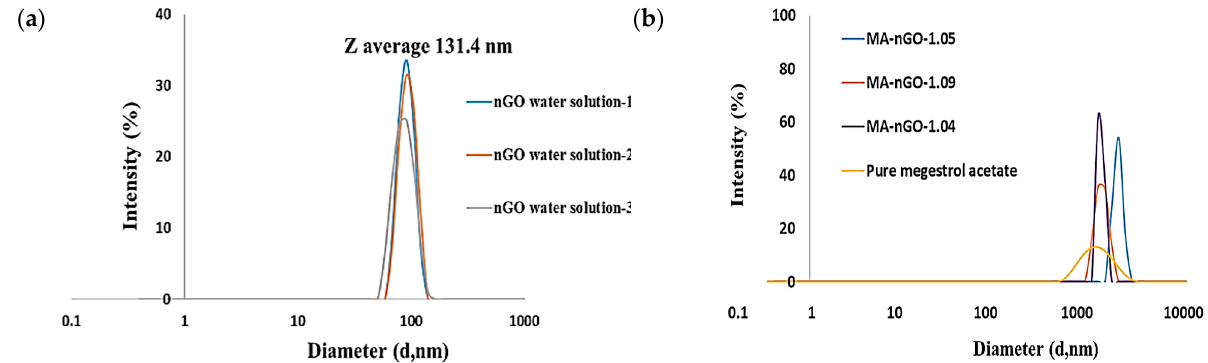
Figure 1. Zetasizer particle size measurement of ( a ) nano graphene oxide (nGO) and ( b ) megestrol acetate (MA)-nGO composite.